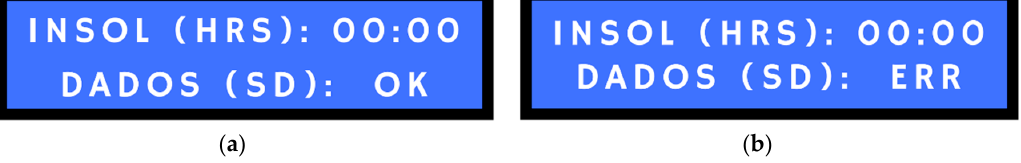
Figure 4. The user interface: ( a ) situations of compliance; ( b ) situations of error in data storage.